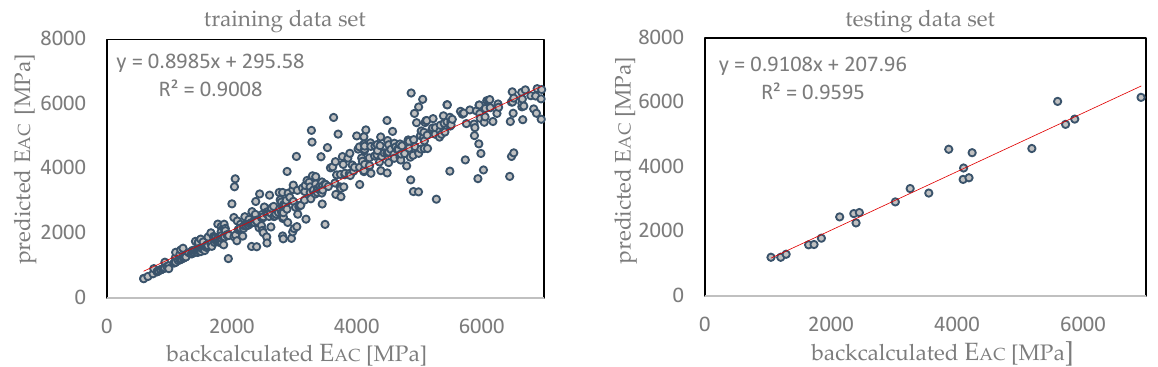
Figure 7. Comparison of predicted E AC with backcalculated E AC —Model ANN.